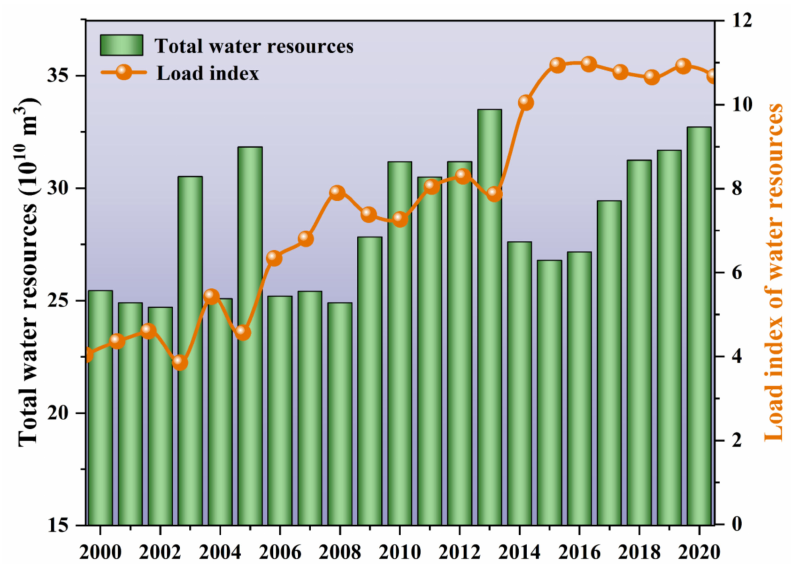
Figure 2. Time-dependent trends of water resources consumption and water load index in Northwest